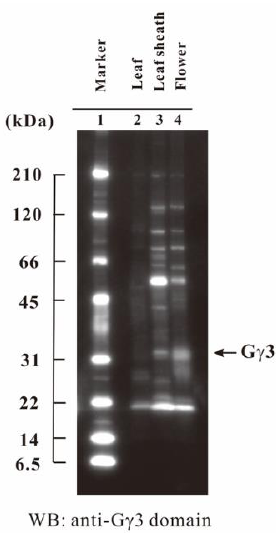
Figure 6. Tissue-specific accumulation of G γ 3 in the wild-type (WT). Ten micrograms of each of the plasma membrane fraction proteins of the leaf, leaf sheath, and flower in the WT was analyzed by SDS-PAGE and Western blotting using an anti-G γ 3 domain antibody. Molecular weight marker (lane 1); leaf from etiolated seedling (lane 2); developing leaf sheath at the eighth leaf stage (lane 3); 1–5 cm flower (lane 4).